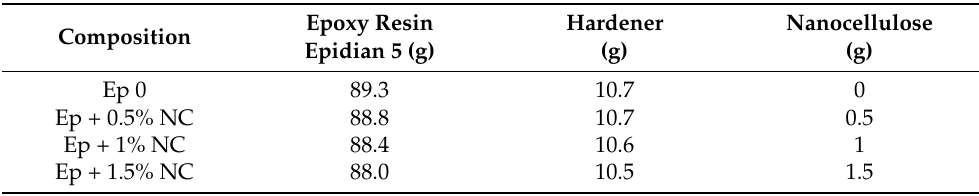
Table 3. Content of the